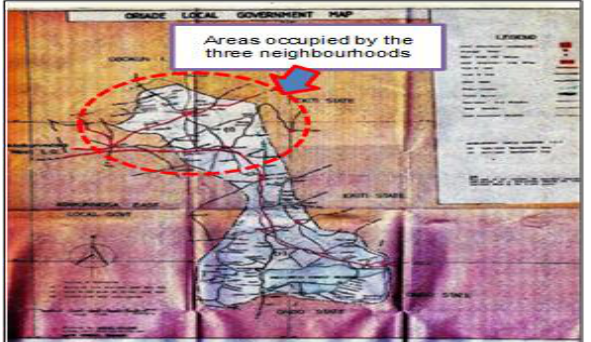
Figure 2. Case study map. (Source: Oriade local government local authority board)